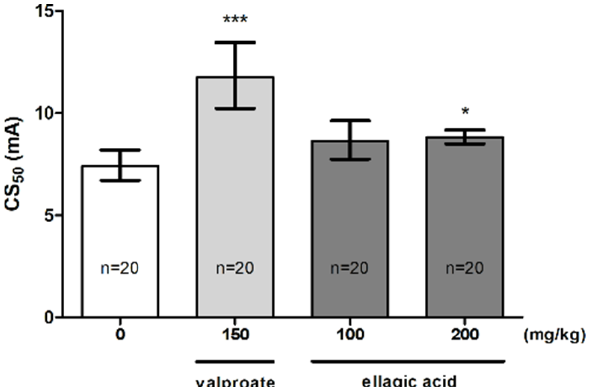
Figure 3. Effect of ellagic acid on the seizure threshold in the MEST test in mice. Ellagic acid and valproate (positive control) were injected i.p. at 60 and 15 min before the test, respectively. The doses are shown on the abscissa. Control animals received 0.5% methylcellulose. Data are expressed as CS 50 (in mA) values with 95% confidence limits. Each CS 50 value represents the current intensity predicted to produce convulsions in 50% of mice. * p < 0.05, *** p < 0.001 vs. the control group (one-way ANOVA followed by Dunnett’s post hoc test).